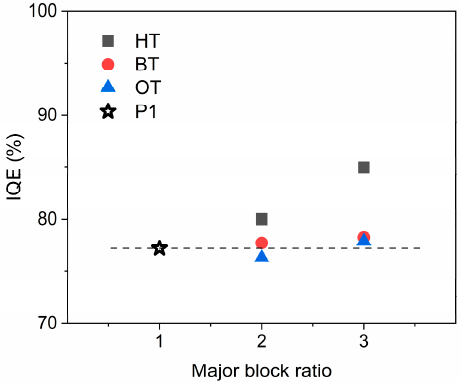
Figure 10. Calculated IQE of the block copolymer devices using the IPCE values at 500 nm shown in Figure 9.